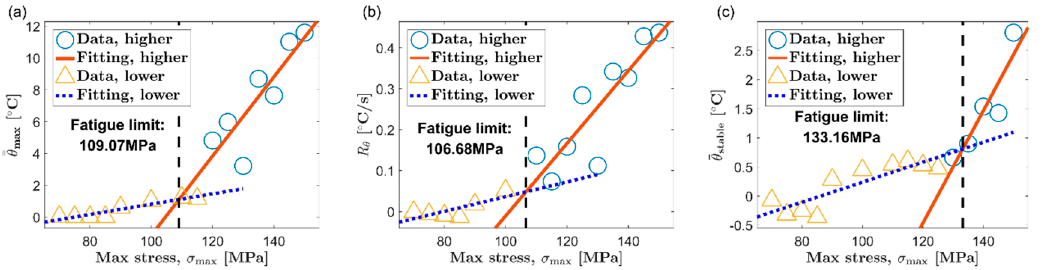
Figure 10. Fatigue limit evaluation using the Luong method, ED: ( a ) maximum temperature rise, 𝜃̿ (cid:2923)(cid:2911)(cid:2934) ; ( b ) initial temperature rise slope, 𝑅 (cid:3087) ; ( c ) mean temperature rise of stable phase,